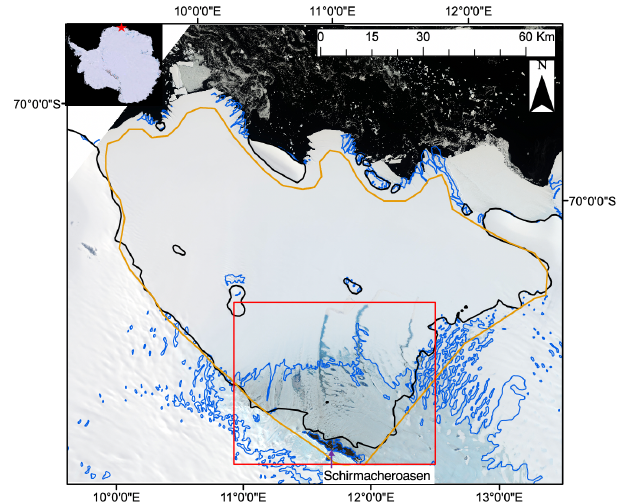
Figure 1. A map of the study area. The base image is a mosaicked RGB Sentinel-2 image of the Nivlisen Ice Shelf acquired on 26 January 2017. The solid black line marks the grounding line, according to the NASA Making Earth System Data Records for Use in Research Environments (MEaSUREs) Antarctic boundaries dataset (Mouginot et al., 2017). The solid blue line represents the blue ice areas in the region according to Hui et al. (2014). The solid orange line roughly delineates the ice shelf and shows the study area extent used for this study, and the solid red line marks the area shown in all subsequent figures. The red star on the inset shows the location of the Nivlisen Ice Shelf in the context of an image of Antarctica, which is a mosaic product based on sources from USGS, NASA, National Science Foundation, and the British Antarctic Survey (https://visibleearth.nasa.gov/images/78592/ landsat-image-mosaic-of-antarctica, last access: 10 July 2020).